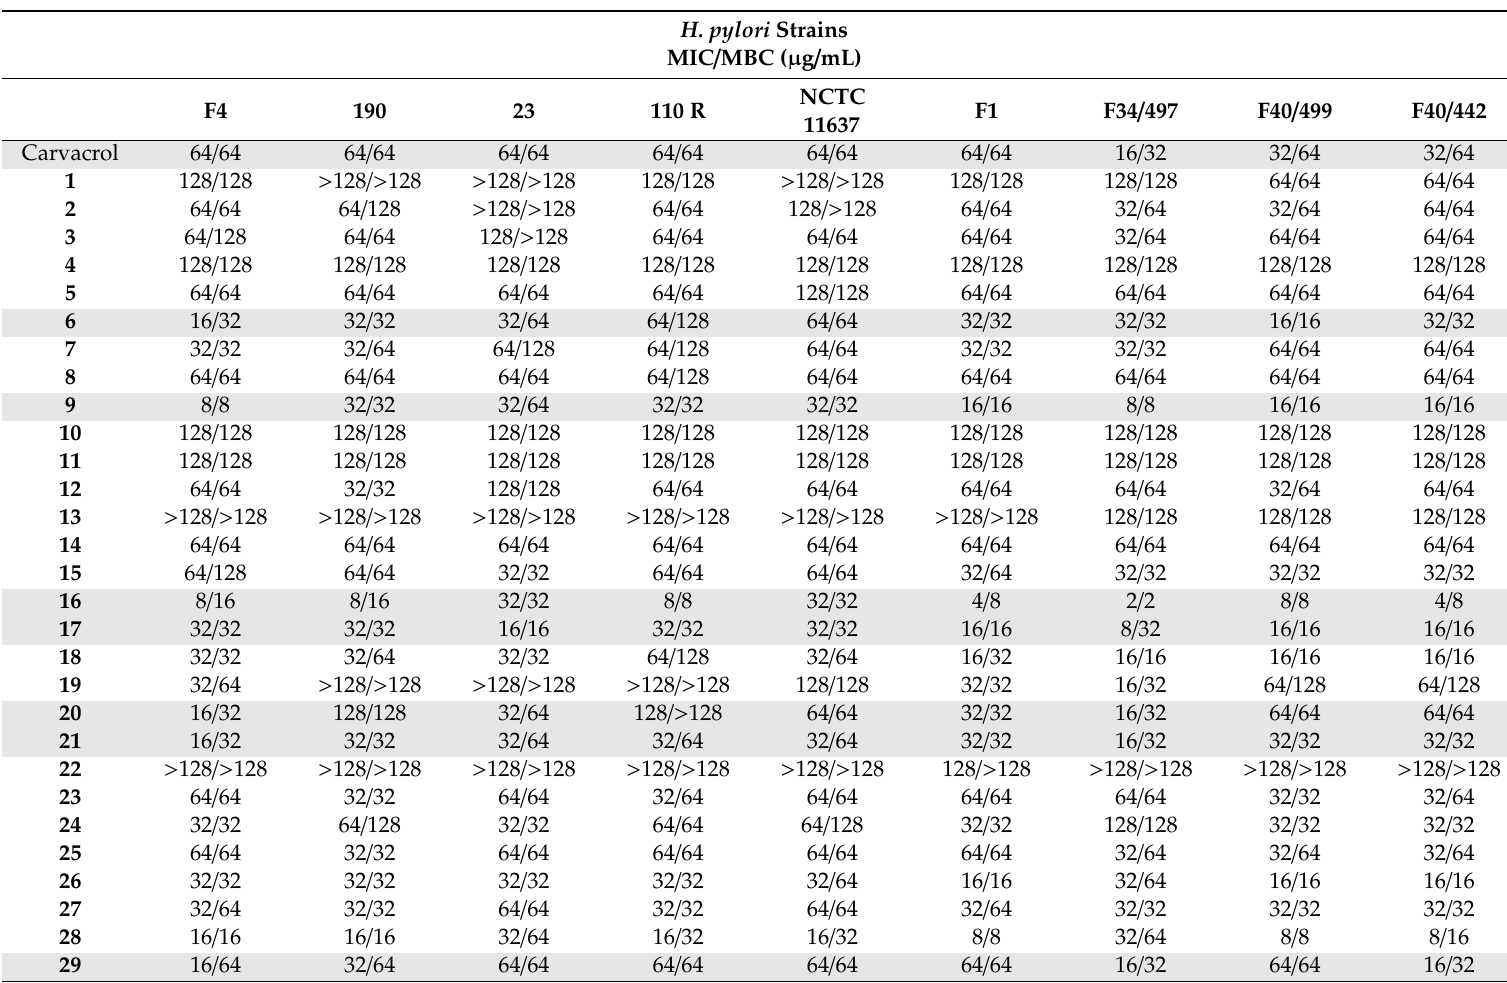
Table 1. MIC and MBC values for carvacrol (parent compound) and its semi-synthetic derivatives ( 1 – 46 ) against nine strains of H. pylori . Antibiotic susceptibility is reported for each H. pylori